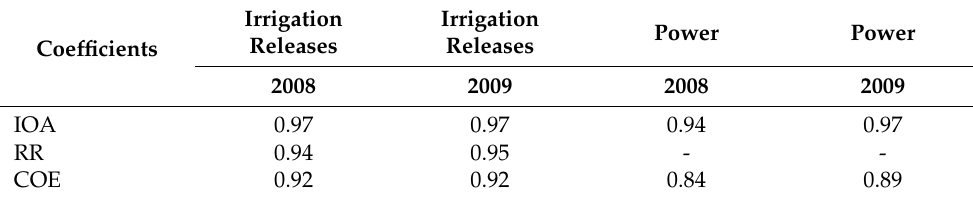
Figure 23. Validation of the Model for Irrigation Releases (2008 and 2009). Table 7. Model efficiency parameters for Model Validation for year 2008 and